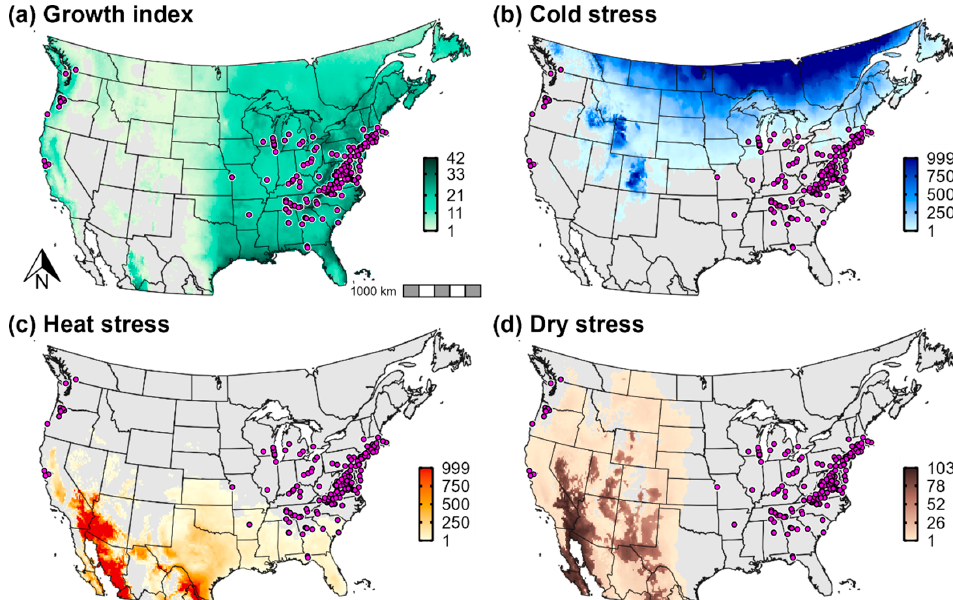
Figure 7. Population growth and climate stress accumulation for Calonectria pseudonaviculata in the contiguous United States and bordering areas in North America. Population growth in CLIMEX is measured as the ( a ) annual growth index (range = 0–100). Climate stress indices (range = 0–999) include ( b ) cold stress, ( c ) heat stress, and ( d ) dry stress. Pink circles depict the approximate locations of all presence records for the region.